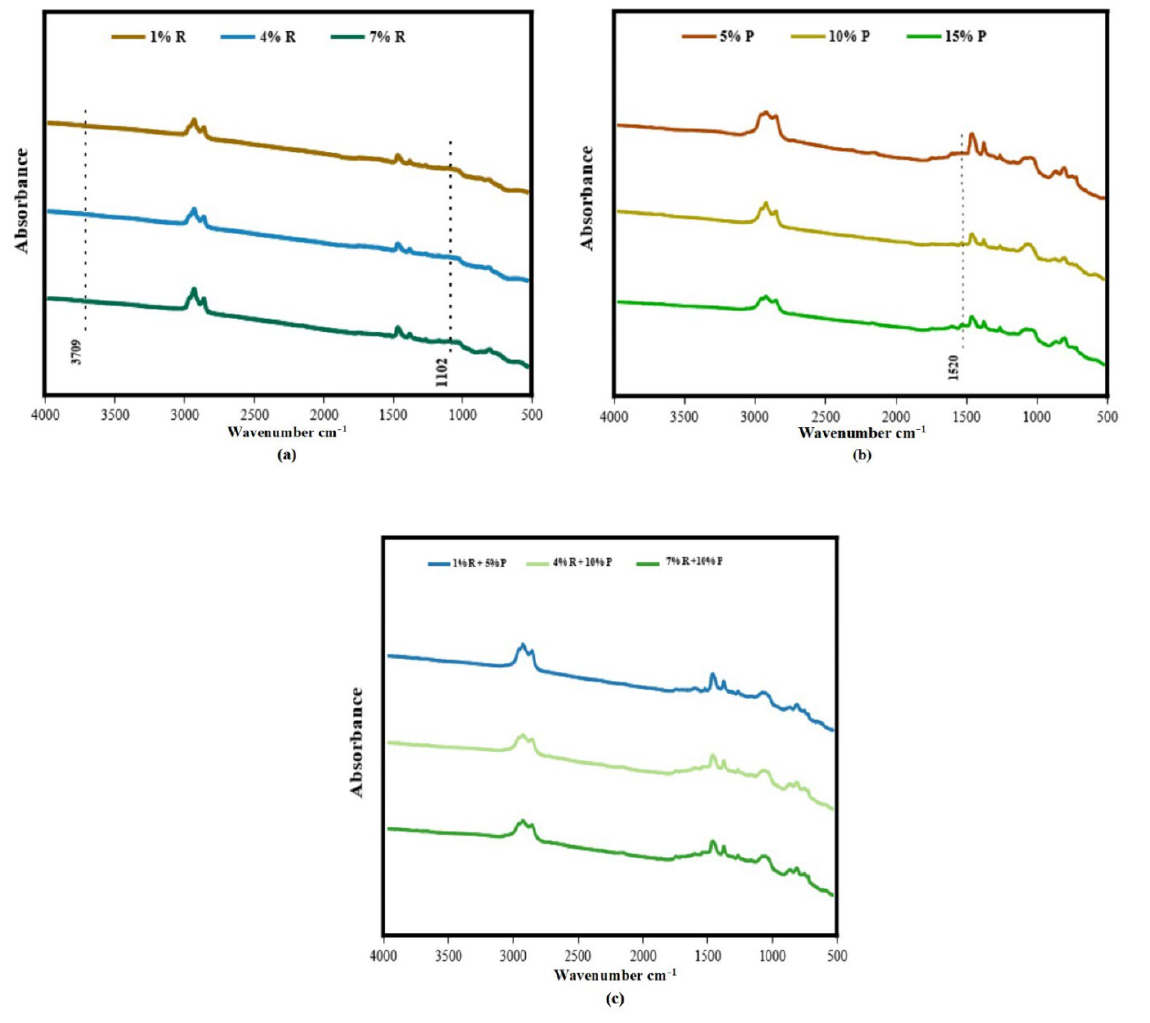
Figure 12. FTIR spectra of ( a ) R-modified asphalt, ( b ) P-modified asphalt, ( c ) (1% R + 5% P), (4% R + 10% P), and (7% R + 10% P)-modified asphalt.